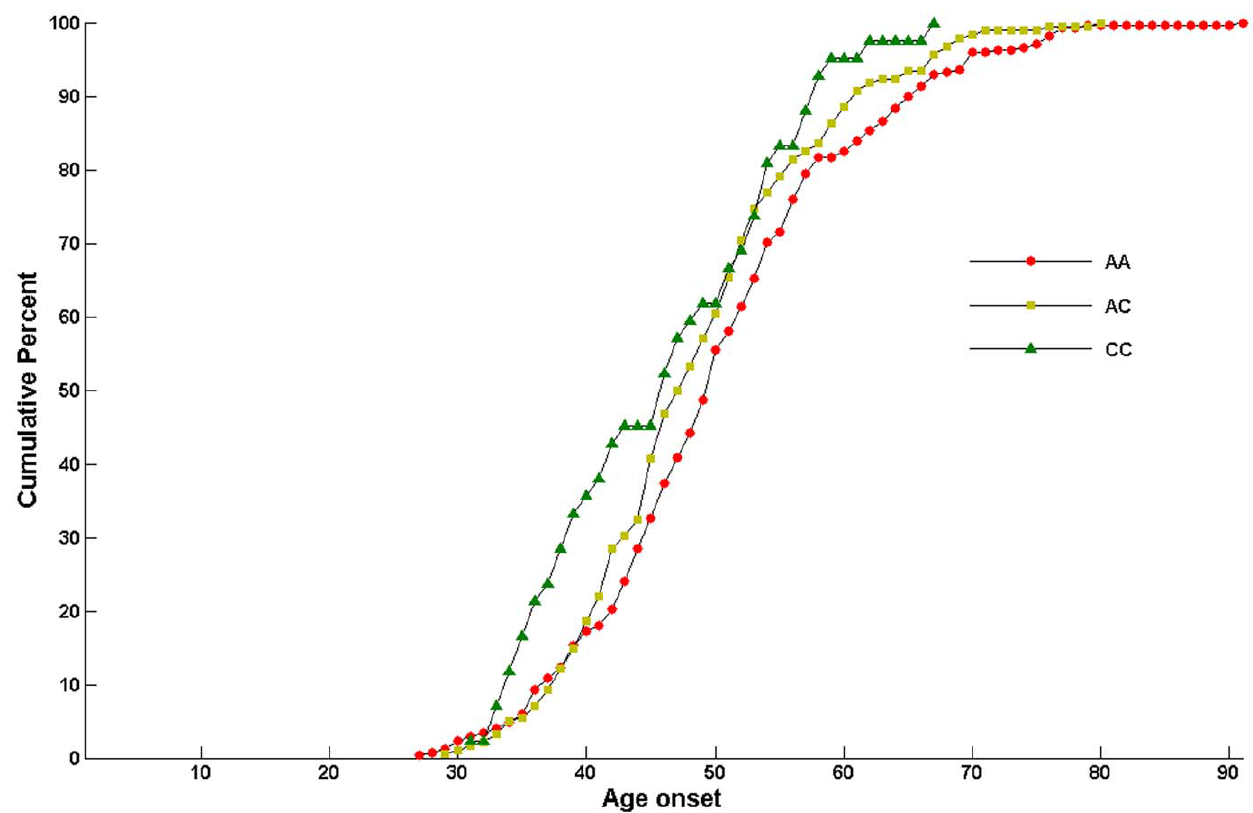
Figure 1. Age at onset of breast cancer and variants of IL23R gene.